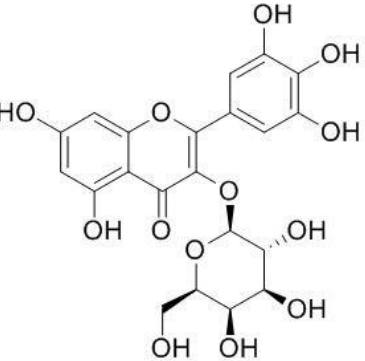
Figure 2. The chemical structure of myricetin 3-rhamnoside (M3R).